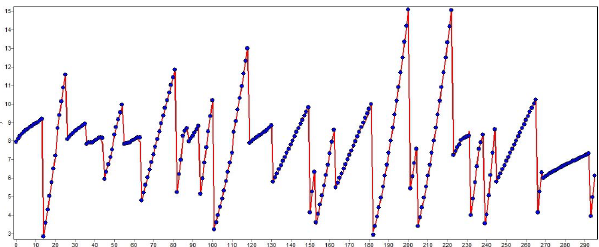
Figure 17. The fitting curve of Eq. (22) ( x 5 ).